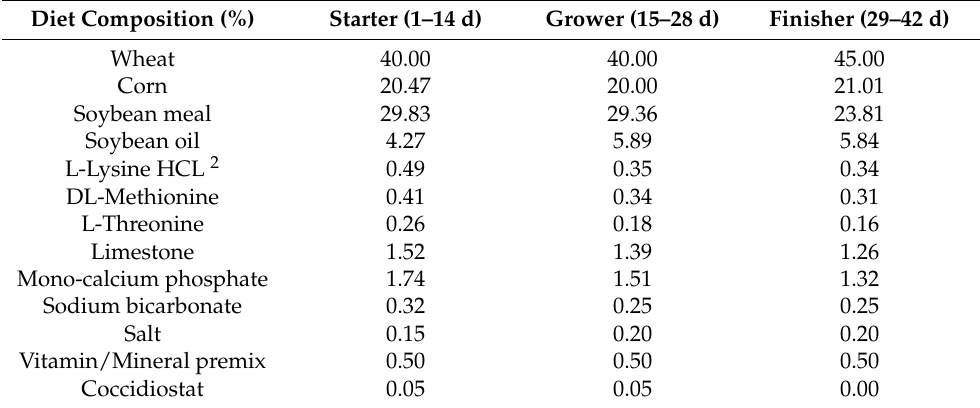
Table 1. Ingredient composition of the experimental diets 1 .